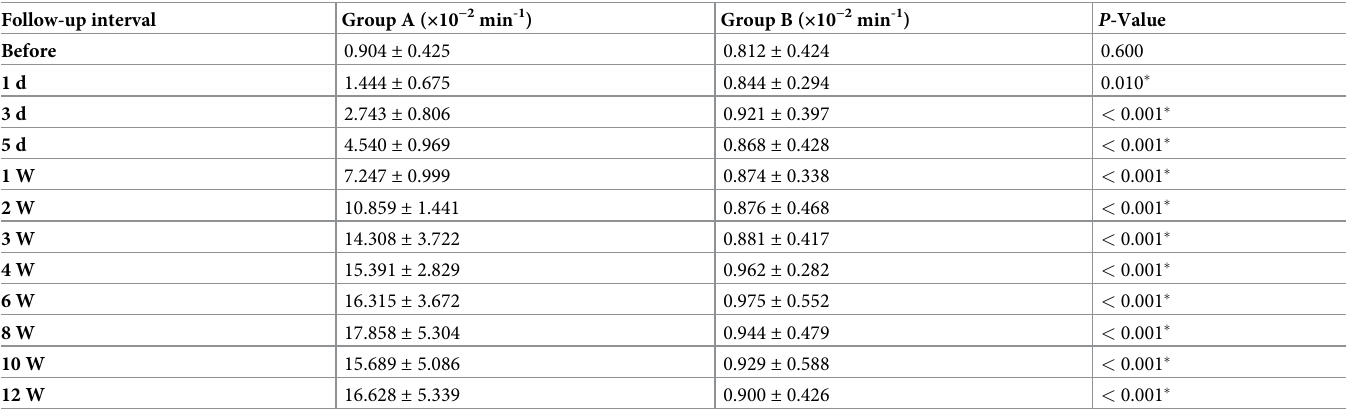
Table 2. Mean K trans values for each injury